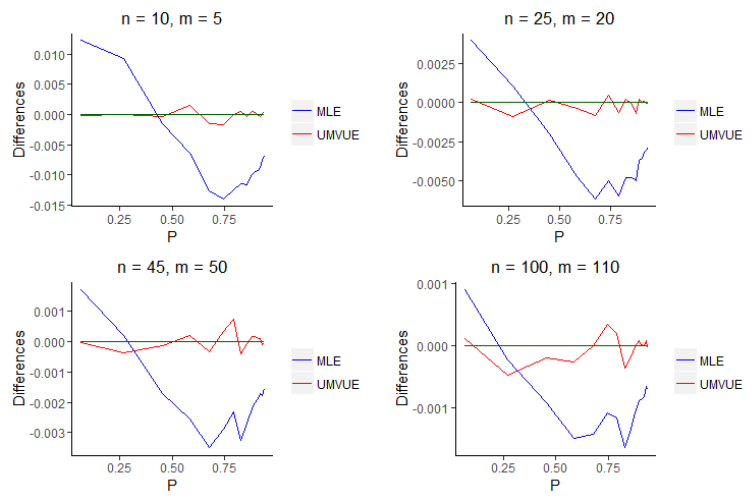
Figure 6 – Estimated bias of the UMVUE and MLE of P for different sample